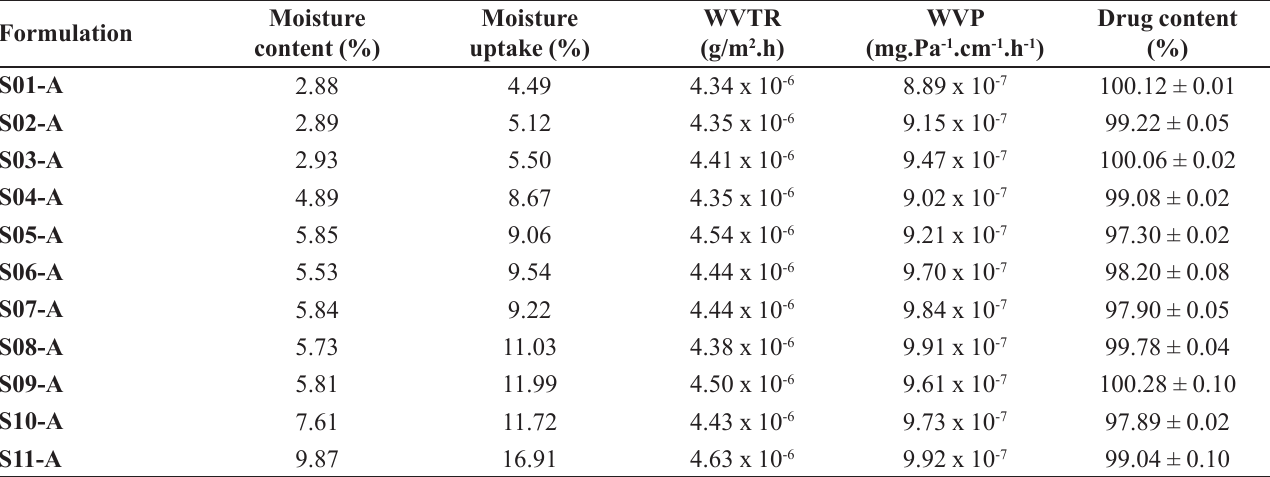
TABLE IV - Results for moisture content, moisture uptake, water vapor transmission rate (WVTR) and water vapor permeability (WVP) of transdermal patches of TZD HCl